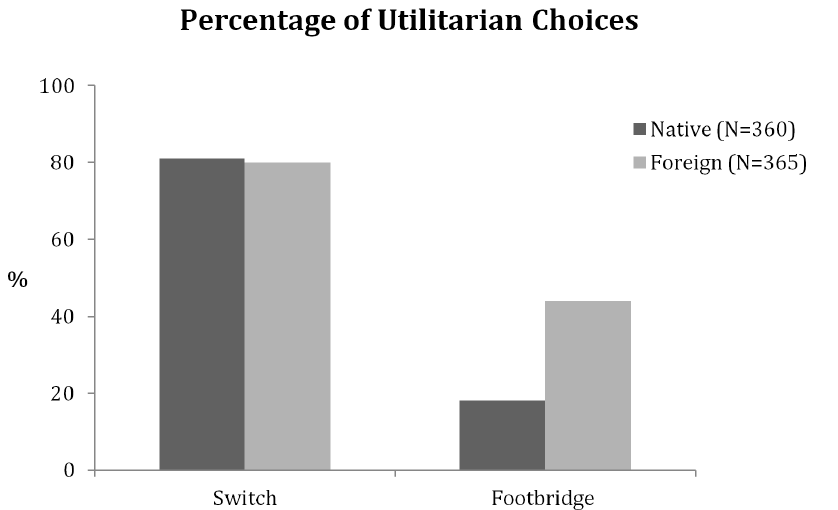
Figure 1. Percentage of utilitarian decisions (Experiment 2). Percentage of utilitarian decisions for the two versions of the trolley problem in the native language condition and the foreign language condition.